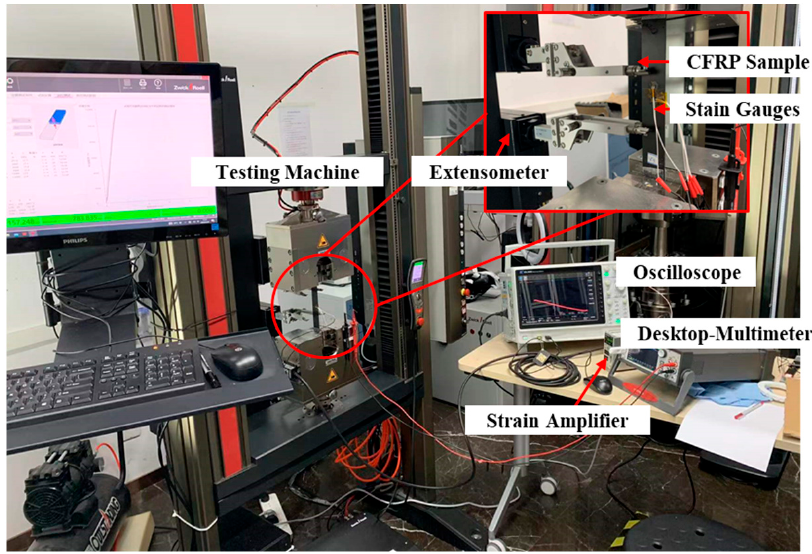
Figure 1. Experimental setup of static loading.